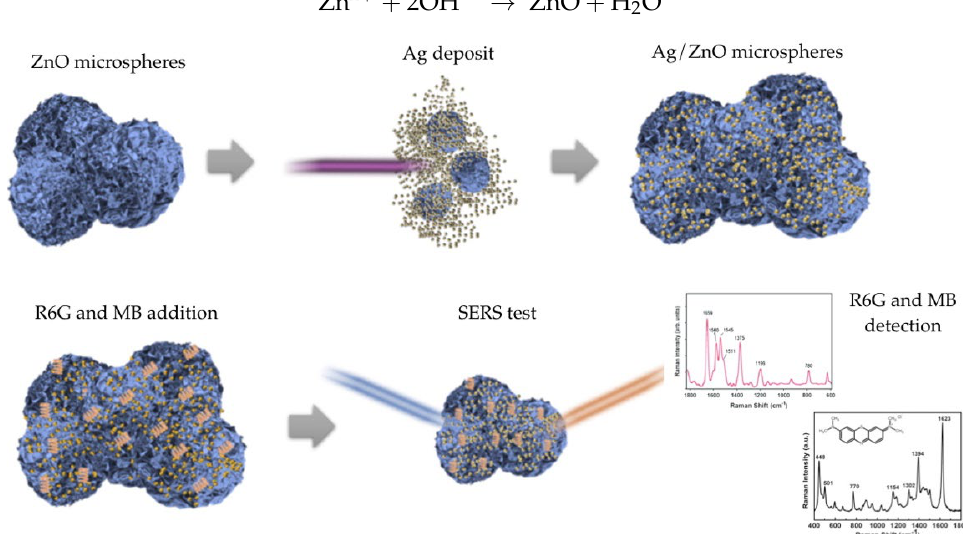
Figure 1. Hierarchical Ag/ZnO MSs based SERS substrates for organic molecules detection.